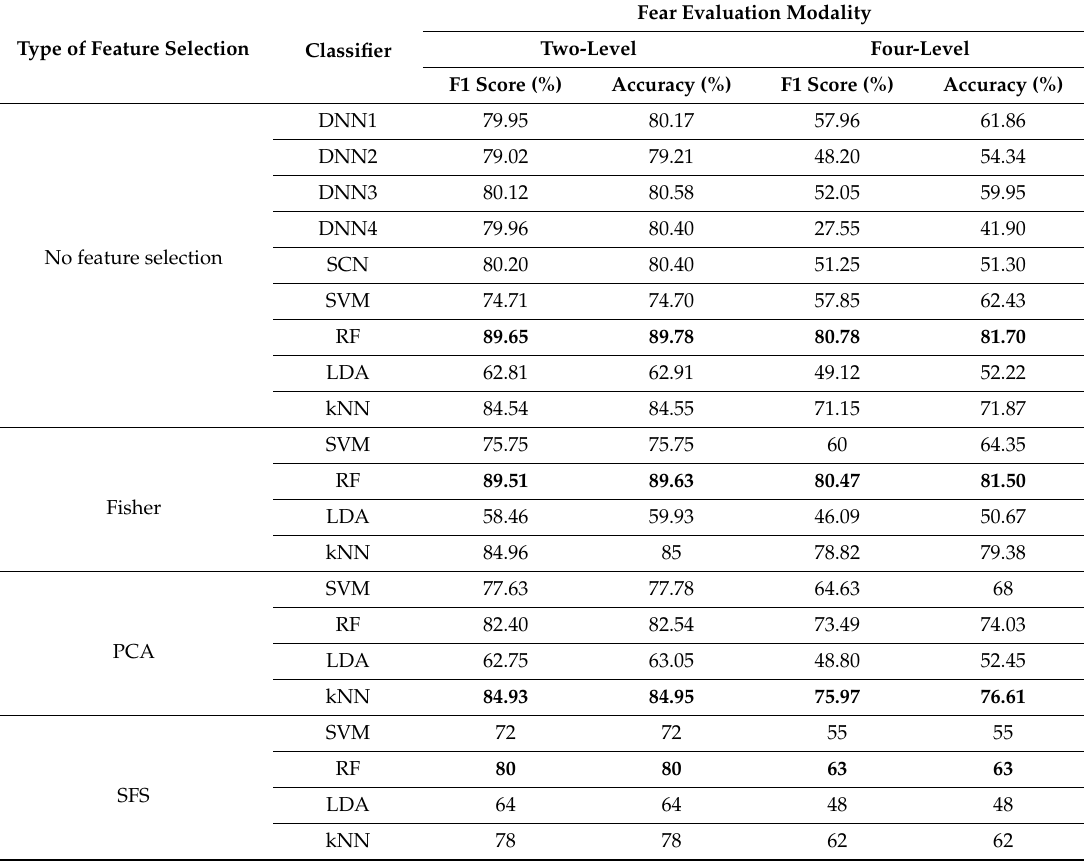
Table 7. Classification accuracy when input is a vector of 32 Approximate Entropies and eight peripheral signals. (The highest accuracies are written with